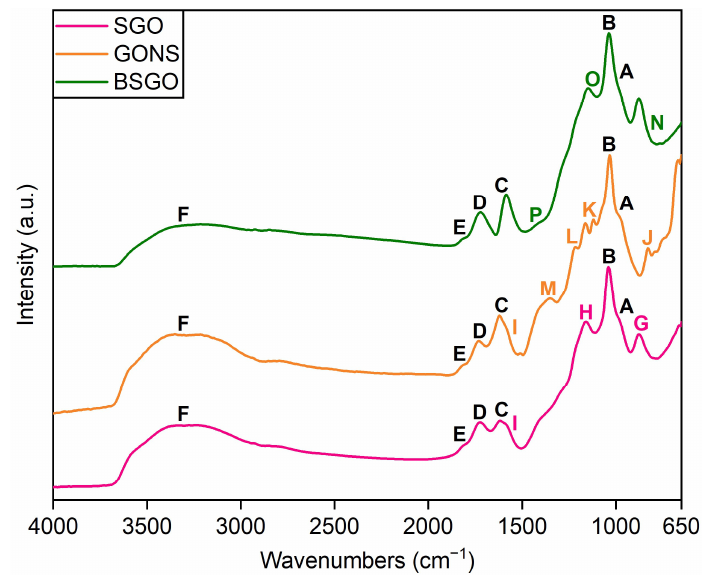
Figure 2. ATR-FTIR spectra of the proposed GO-based membranes.